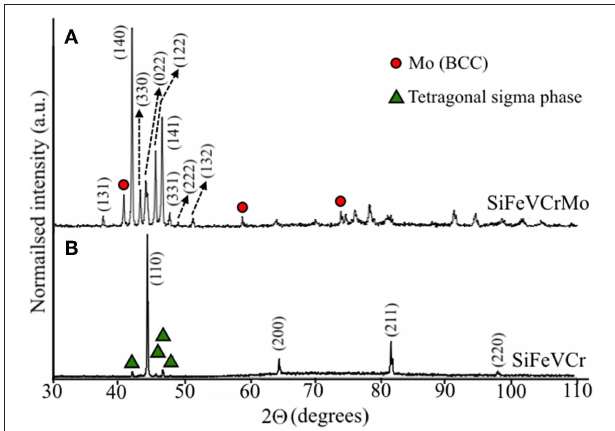
FIGURE 1 | Room temperature XRD patterns from the as-cast SiFeVCrMo (A) and SiFeVCr (B) samples. The circles indicate peaks attributed to BCC Mo. The triangles indicate peaks attributed to a tetragonal